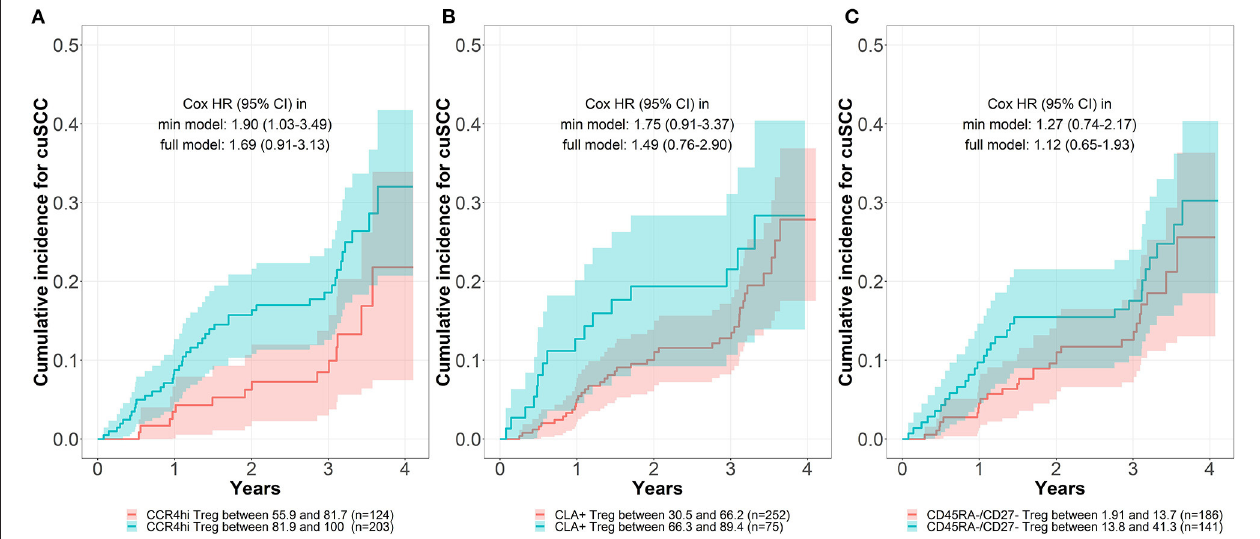
FIGURE 1 | Cumulative incidence for cutaneous squamous cell carcinoma (cuSCC) by baseline levels of circulating Tregs. The cumulative incidence for cuSCC stratified by levels of baseline circulating Treg, separately for CCR4hi Treg (A) , CLA + Treg (B) , and CD45RA − /CD27 − Treg cells (C) , as determined by the reduced monotonic regression in combination with visual inspection of the cumulative incidence curves. Hazard ratios (HR) and 95% confidence intervals (CI) were calculated using Cox proportional hazard models. The minimum (min) model was adjusted for age and sex, and the full model was further adjusted for self-reported skin reaction to 1h of sun